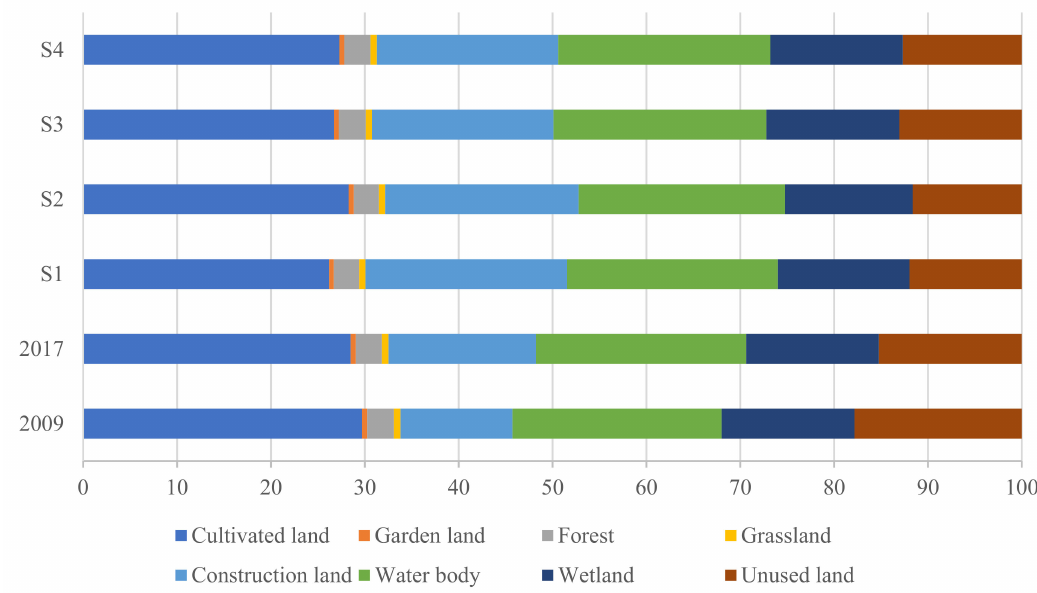
Figure 5. Structure of land use in 2009, 2017 and 2030 under four different